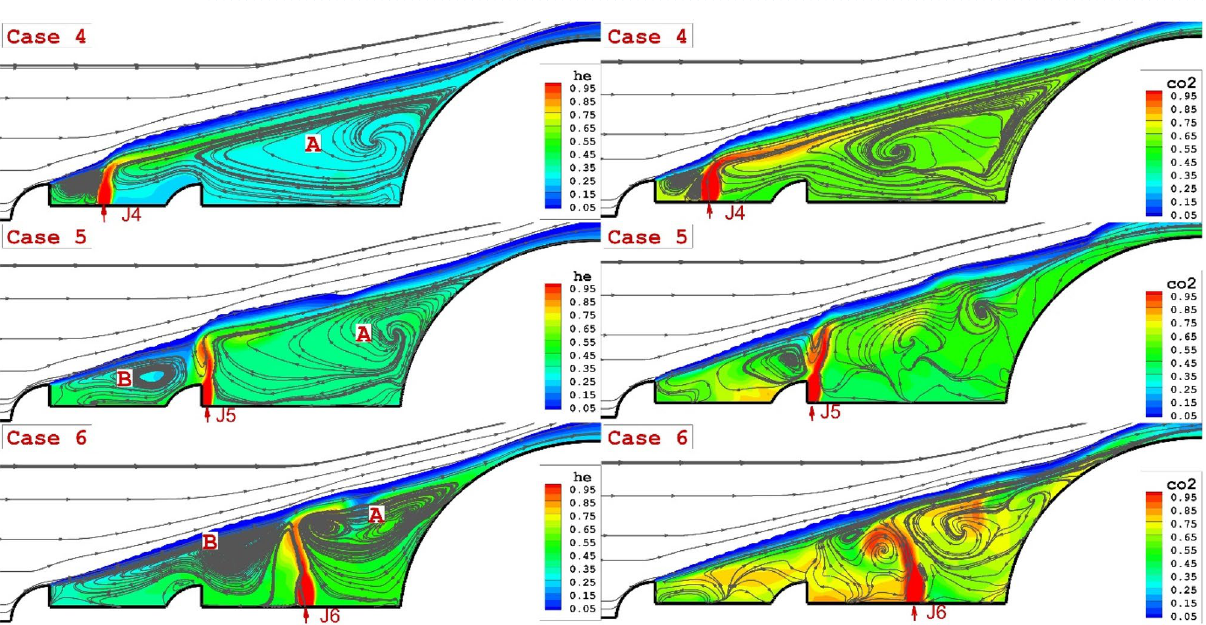
Figure 6. Comparison of helium (left side) and CO 2 (right side) lateral jet for different location on the main